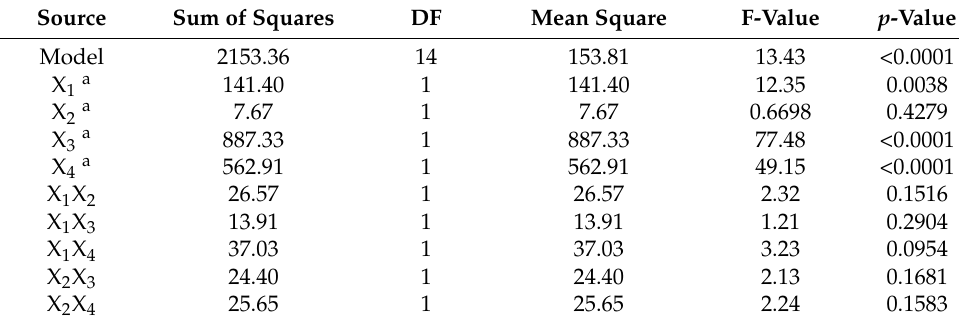
Table 2. ANOVA results from CCD for extraction yields of